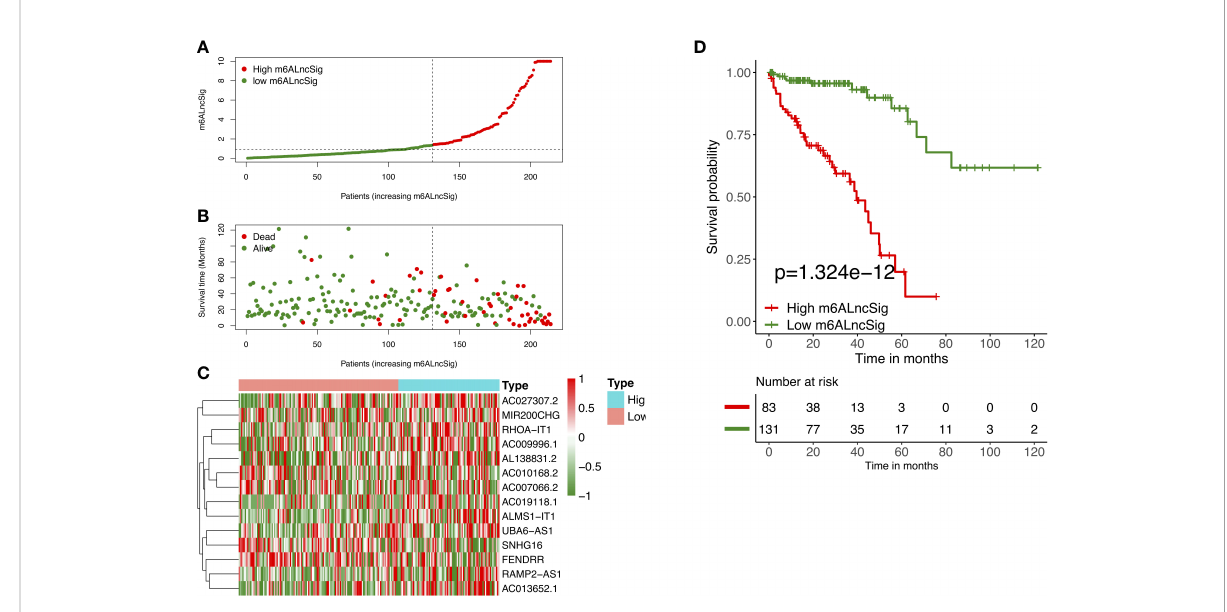
FIGURE 6 Prognostic value of m6ALncSig in the TCGA training set. (A) Distribution of m6ALncSig-based risk score. (B) Survival status along with survival time of COAD patients between high- and low-risk groups. (C) Expression standards of the 14 prognostic m6A-related lncRNAs. (D) KM curves of OS in the high- and low-risk